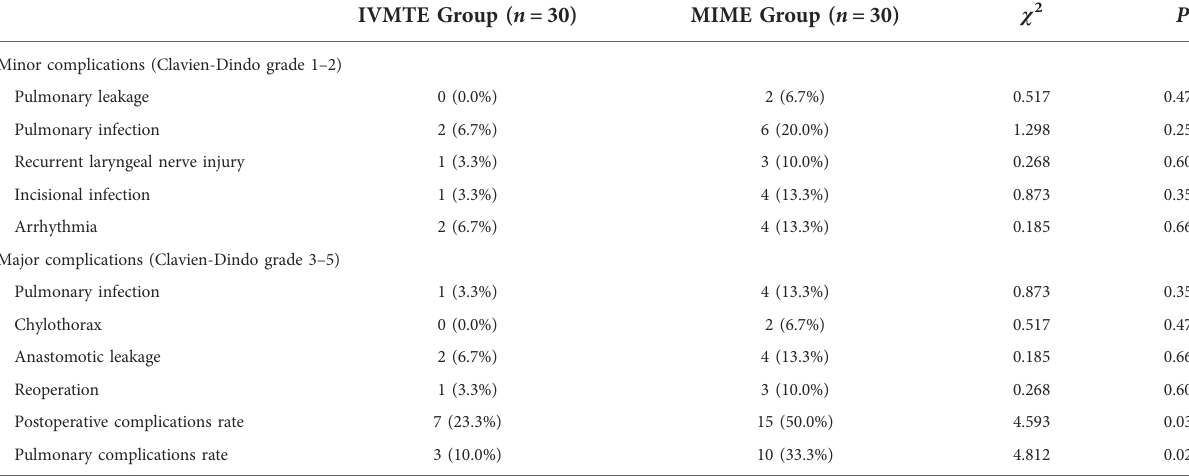
TABLE 3 Comparisons of postoperative complications between the two